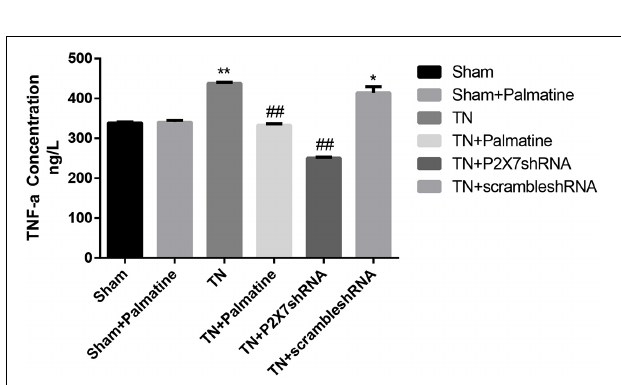
FIGURE 8 | The concentrations of IL-1 β in serum of each group rats determined by ELISA. Values are mean ± SD, n = 6, ** p < 0.01 vs. sham group, ## p < 0.01 vs. TN group.